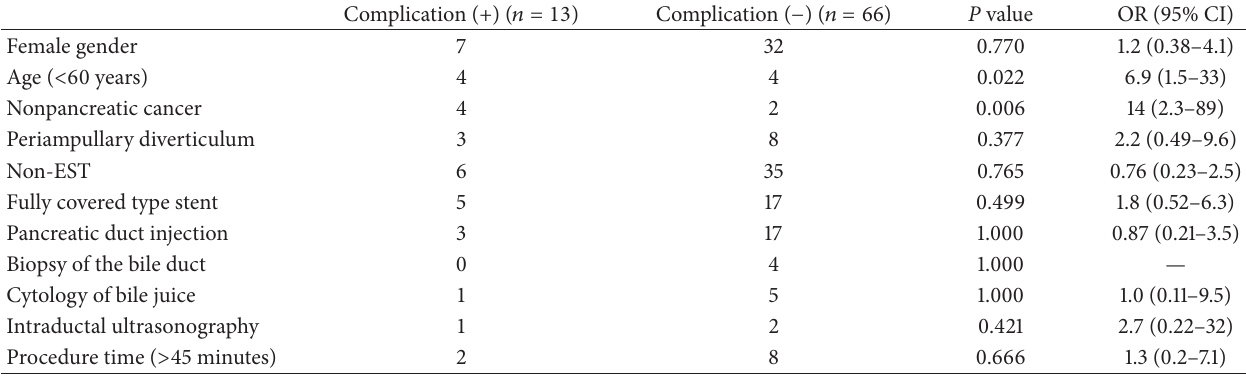
Table 4: Risk factors for overall complications after CSEMS deployment (univariate analysis).